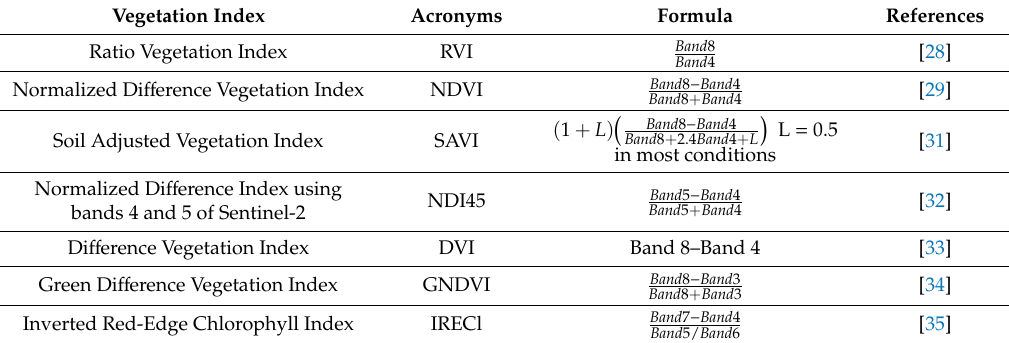
Table 3. List of vegetation indices used in the current